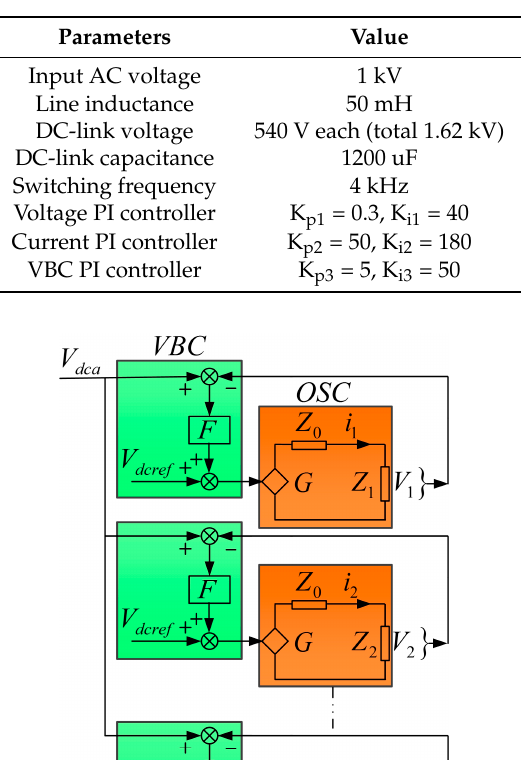
Table 1. Main Parameters of CHBR.